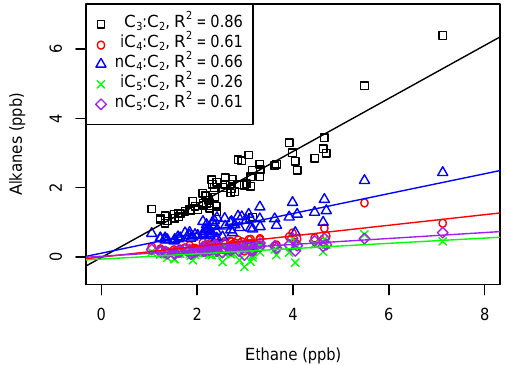
Figure 3. Correlations of propane, butane, and pentane enhance- ments with ethane enhancement. All correlations were highly sta- tistically significant ( p < 0 . 001). While ethane and propane showed the strongest correlation, all alkanes showed a positive correlation with